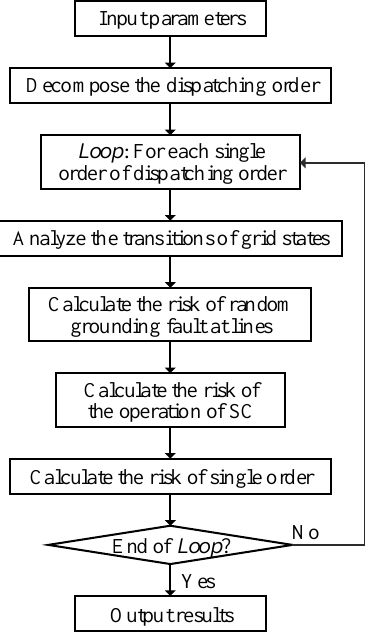
Figure 6. Risk assessment process.